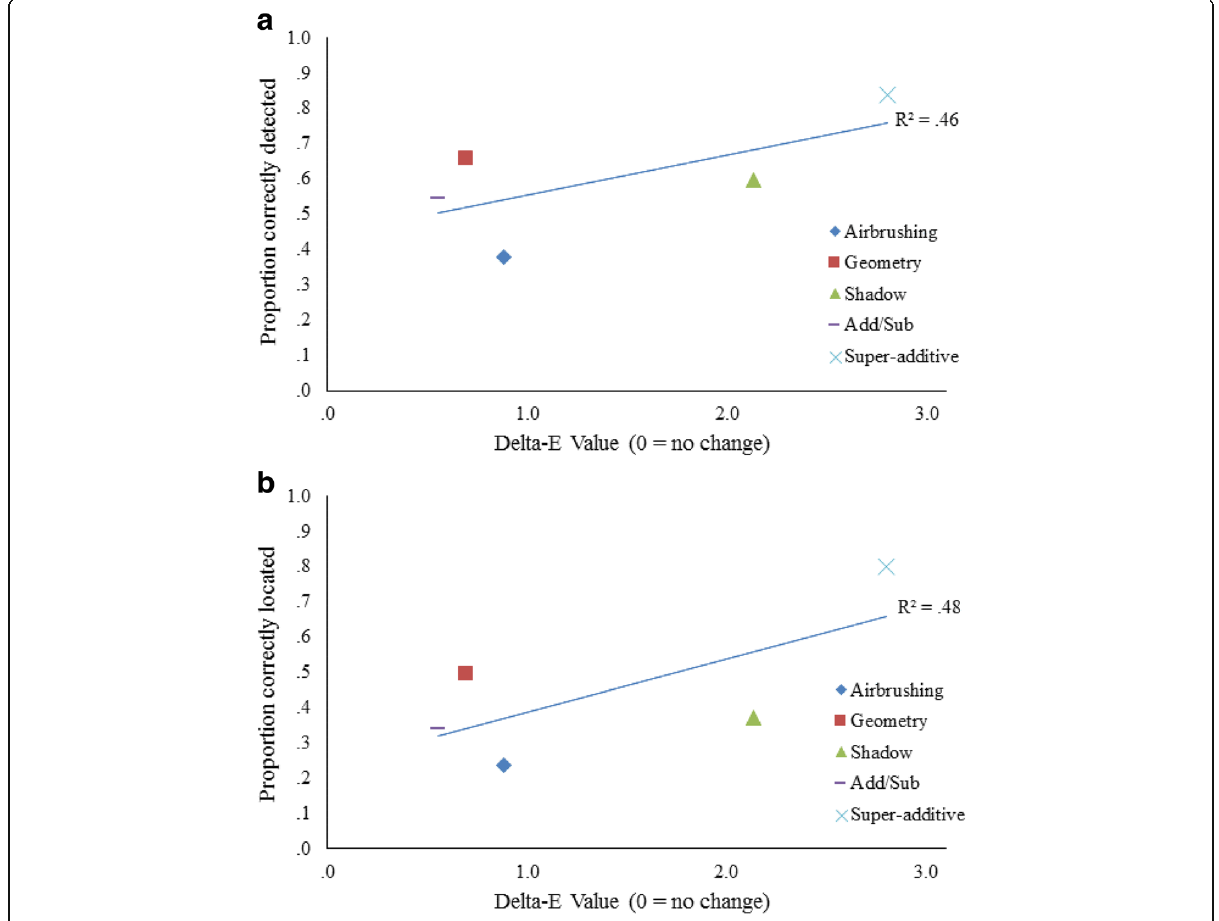
Fig. 6 Mean proportion of correctly detected ( a ) and located ( b ) image manipulations by extent of pixel distortion as measured by Delta-E. The graphs show the mean values for each of the five categories of manipulation